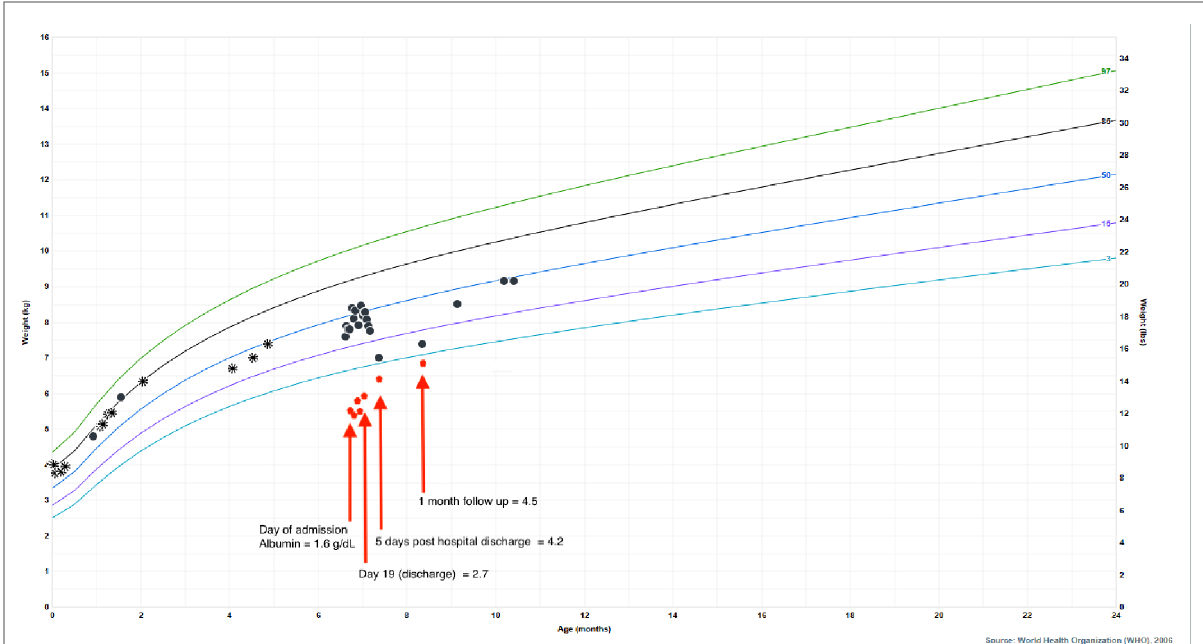
FIGURE 3 Patient ’ s growth chart for weight from birth to present day with superimposed albumin values to highlight the impact of hypoalbuminemia on his falsely reassuring growth curve. Circle points indicate hospital system measurements, asterisk points indicate outside of hospital measurements. Albumin normal lab value range: 3.4 – 4.2 g/dl.